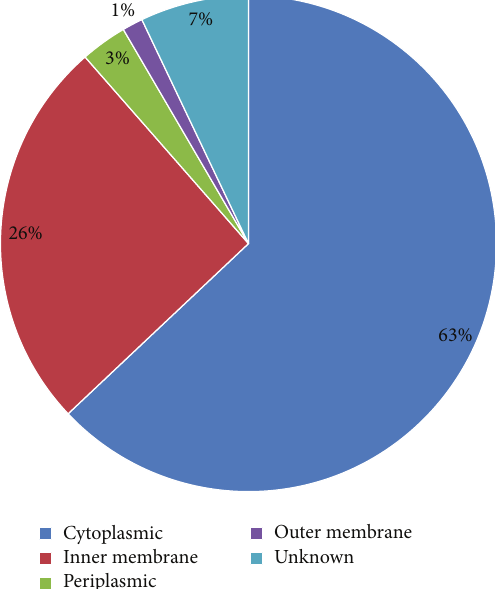
Figure 3: A pie-chart showing the distribution of the drug targets in Dichelobacter nodosus on the basis of their subcellular localization.